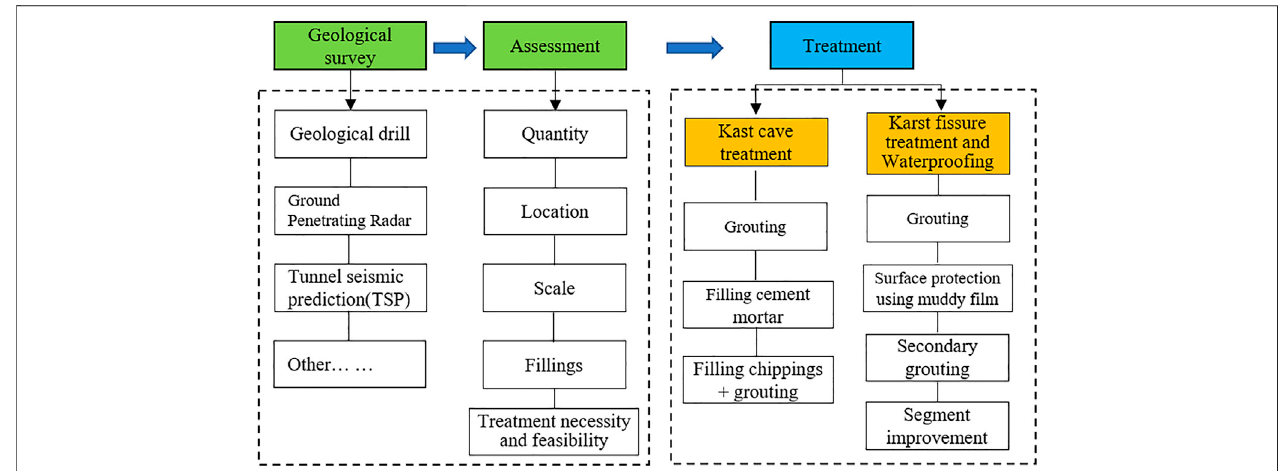
FIGURE 7 | Flow chart of karst cave and fi ssures treatment for karst region along R3 line.